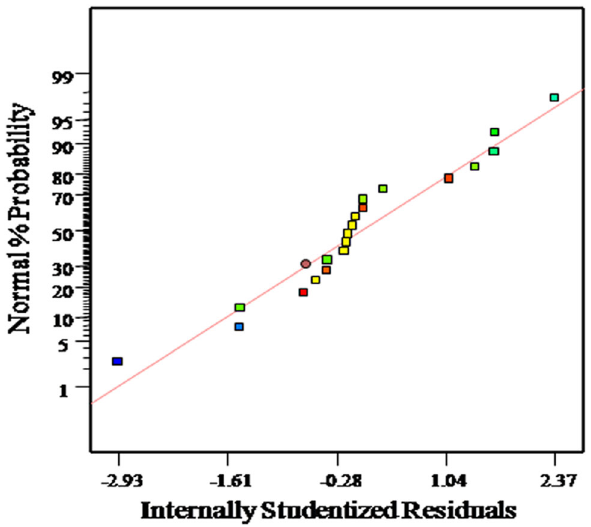
Fig. 4 The studentized residuals and normal % probability plot of CO 2 removal efficiency